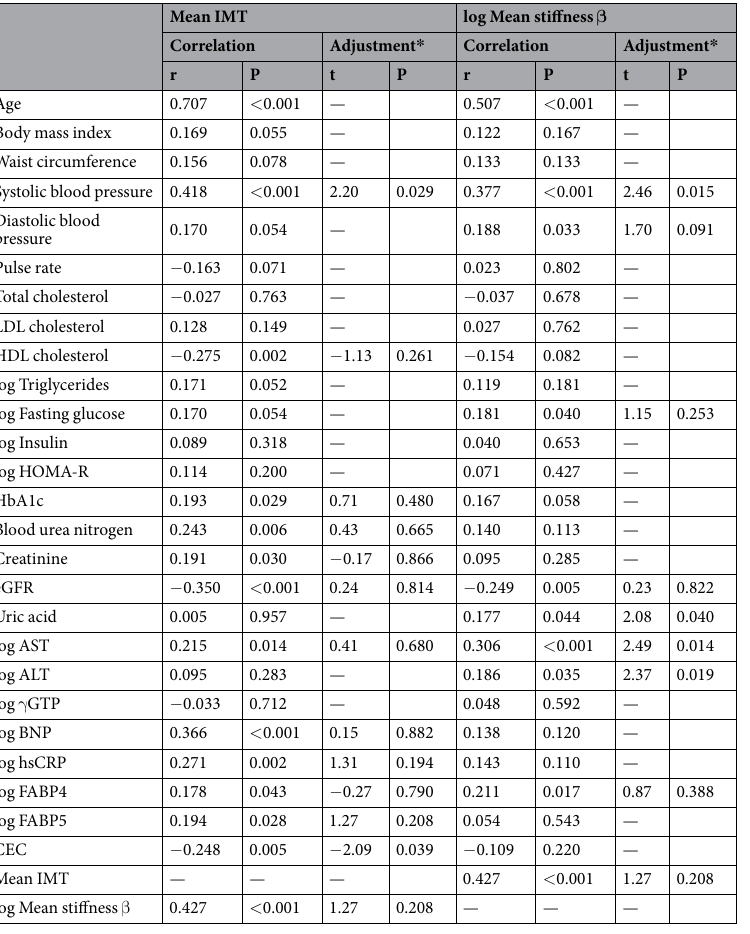
Table 5. Correlation and multiple regression analyses for mean IMT and log mean stiffness β (n = 129). AST, Aspartate transaminase; ALT, Alanine transaminase; BNP, brain natriuretic peptide; CEC, cholesterol efflux capacity. eGFR, estimated glomerular filtration rate; FABP4, fatty acid-binding protein 4; FABP5, fatty acid- binding protein 5. γ GTP, γ -glutamyl transpeptidase; hsCRP, high-sensitivity C-reactive protein; IMT, intima- media thickness. * Adjustment of age and gender in multiple regression